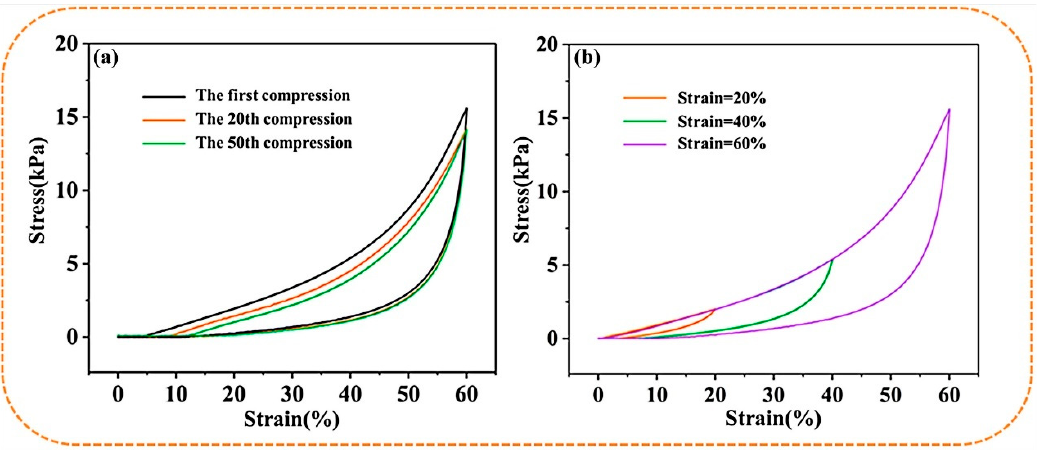
Figure 4. The stress-strain curves of S − PC/CS aerogel as related to ( a ) constant 60% strain and ( b ) various strains.